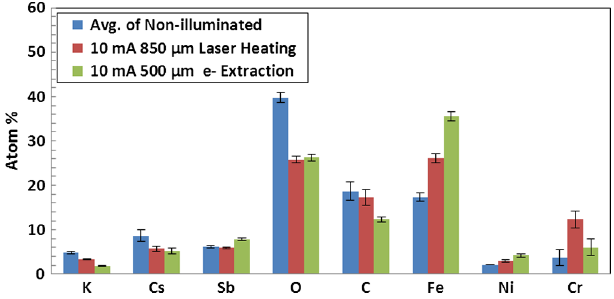
FIG. 21. Chemical assay comparison at locations of photo- cathode #2 that were illuminated with laser light and from unused